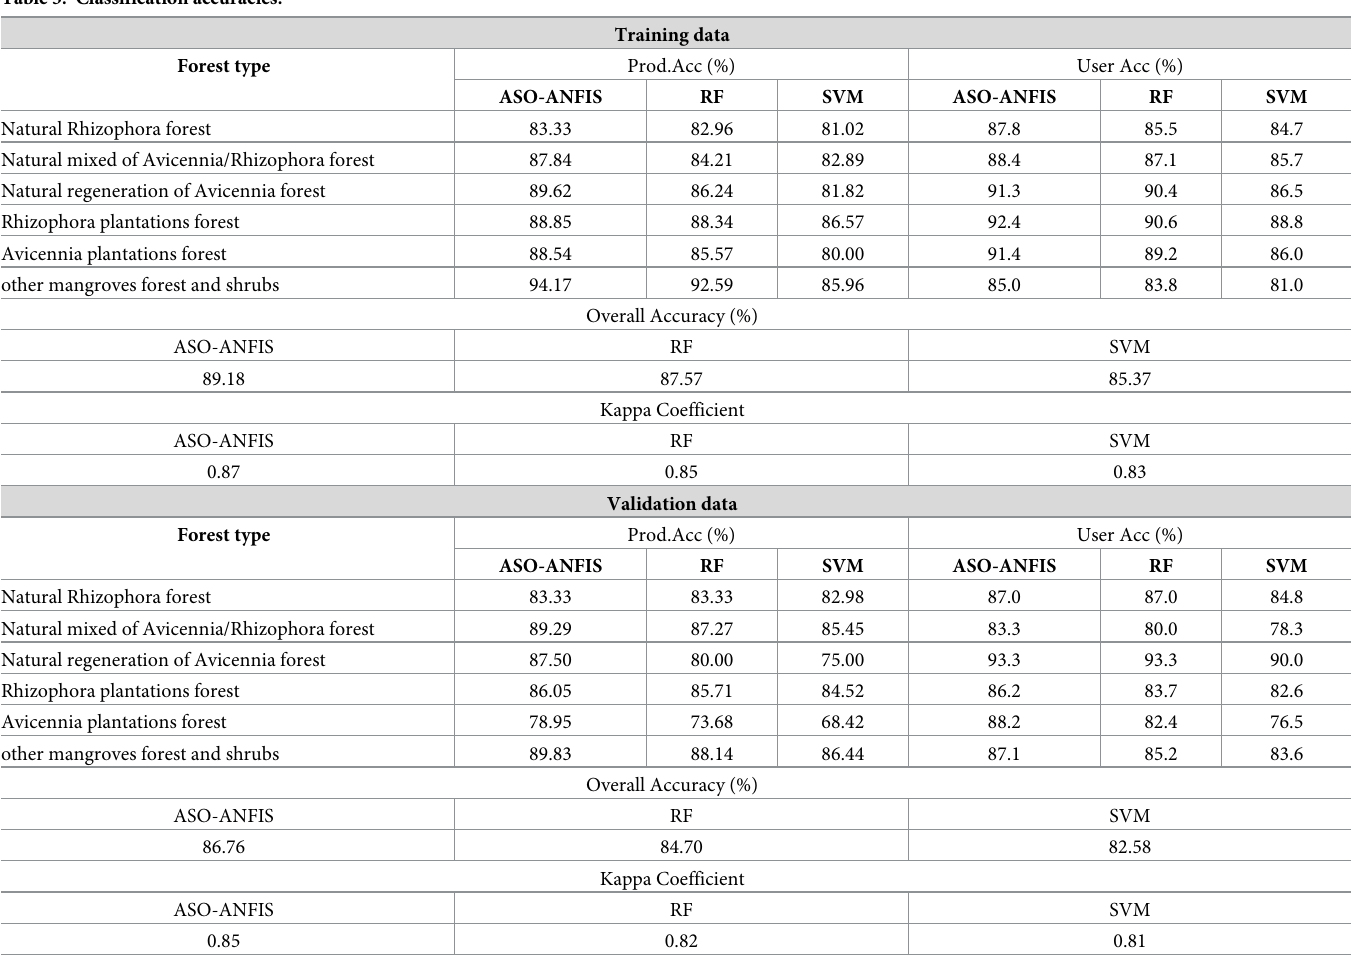
Table 3. Classification